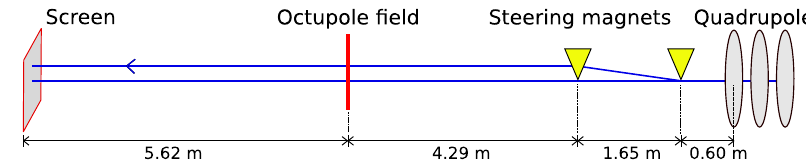
FIG. 1. Schematic of the setup where the beam travels from right to left. Quadrupoles are used for focusing the beam onto the screen and keep a small beam inside the octupole field. The two steering magnets are used to transversely scan the beam inside the octupole field. By observing how the beam changes on the screen at different positions we can deduce information about the beam matrix right before the